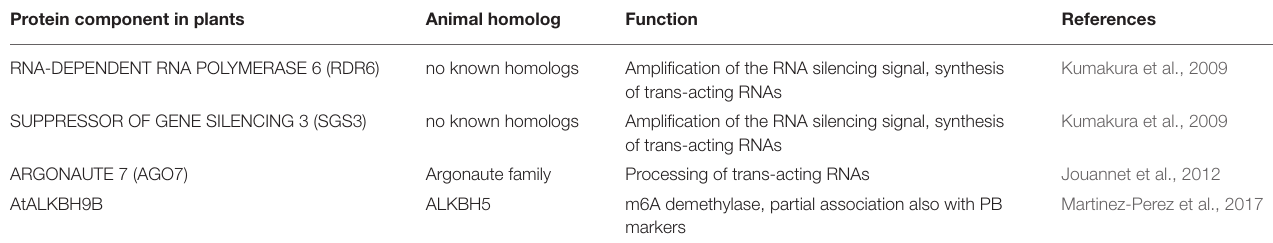
TABLE 3 | Plant siRNA body proteins and their animal counterparts. Protein component in